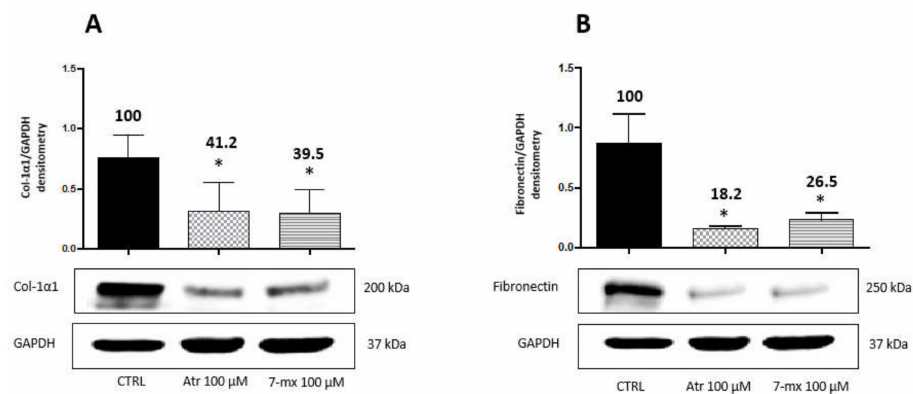
Figure 3. Atropine and 7MX e ff ects on collagen and fibronectin production by HCOF cells. Western immunoblot analysis of collagen type-1 α 1 (Col-1 α 1) and fibronectin in HCOF lysates treated with atropine or 7MX at 100 µ M for 48 h. A representative Western immunoblot is shown at the bottom of each panel, and the quantitative analysis is reported in the histogram above. Numbers on bars indicate the percentage value with respect to the control, set at 100%. Each bar represents the average value ± SD of three di ff erent experiments: ( A ) Col-1 α 1 48 h; and ( B ) fibronectin 48 h. * p < 0.05 vs. CTRL. One-way ANOVA, followed by Tukey’s